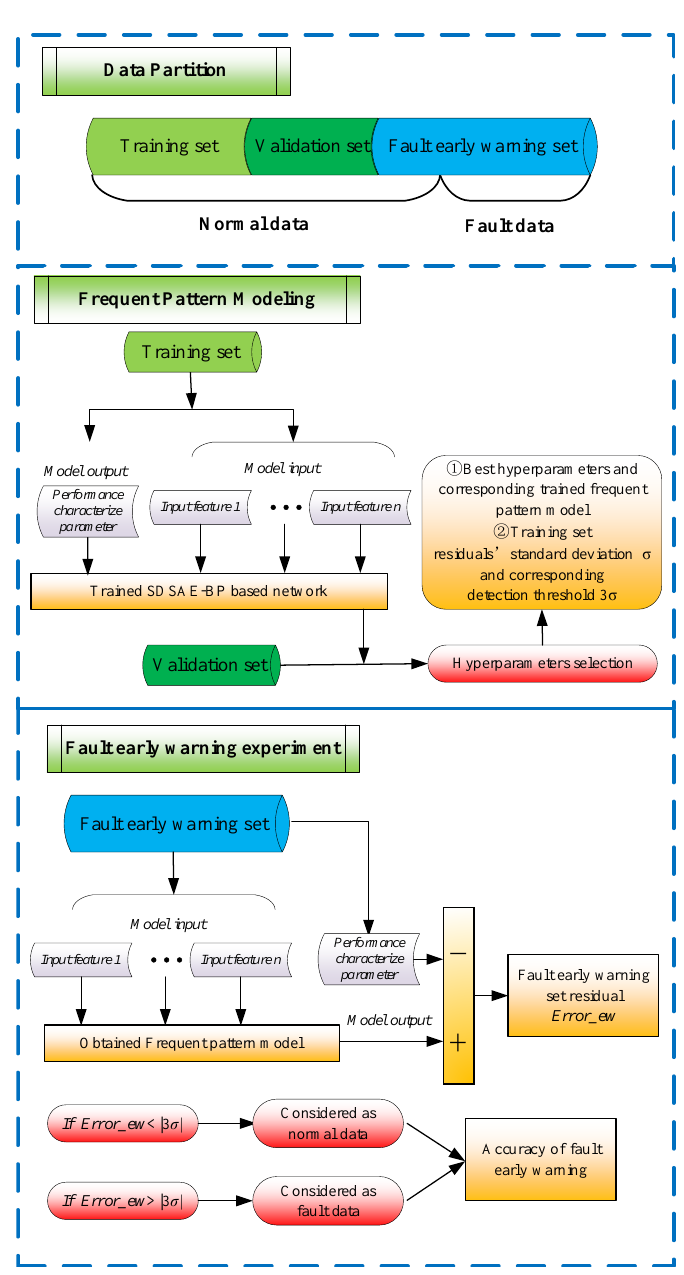
Figure 13. Technical process of the proposed fault early warning method.